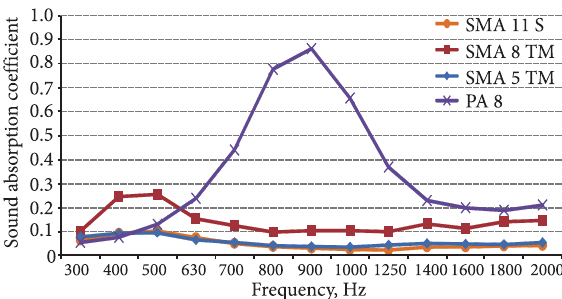
Fig. 10. Sound absorption coefficient measurement results